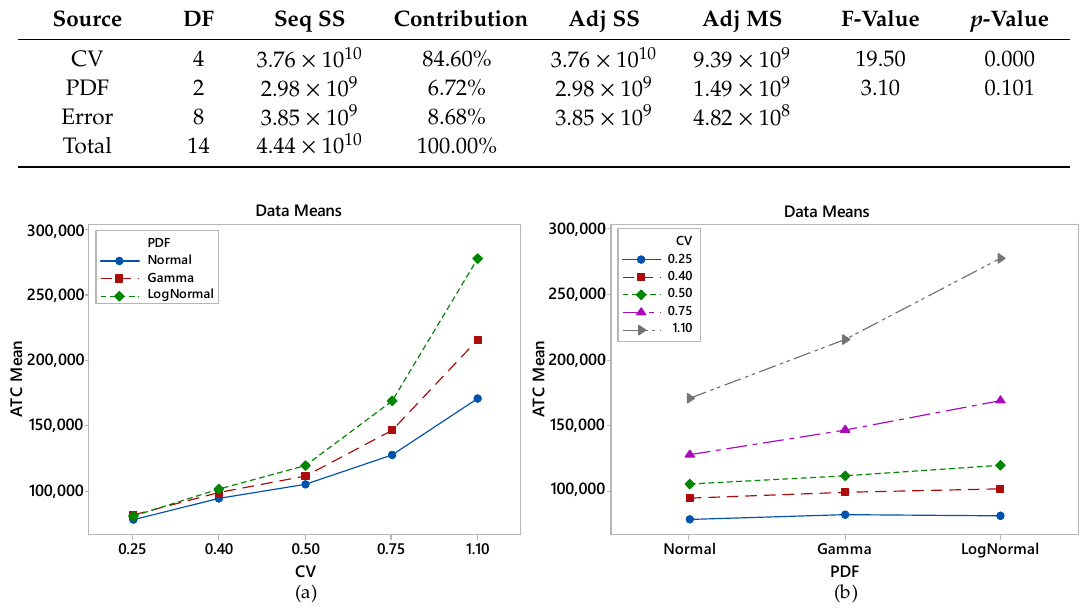
Figure 5. Interaction of distribution types ( pdf) and coe ffi cient of variance ( cv ) : ( a ) cv * pdf and ( b ) pdf Figure 5 . Interaction of distribution types ( pdf) and coefficient of variance ( 𝑐𝑣 ) : ( a ) cv * pdf and ( b ) pdf * cv. *